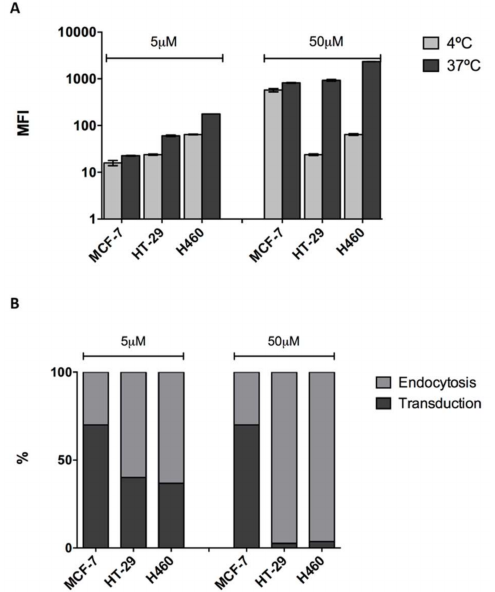
Figure 4. Temperature effect on CIGB-552 internalization evaluated by flow cytometry. ( A ) A reduction in the internalization levels of CIGB-552 was observed at both concentrations used in all the cell lines when assays were performed at 4 ◦ C. However, reduction levels were not the same between cell lines. Both HT-29 and H460 displayed a higher reduction in internalization levels as reflected by values obtained at 37 ◦ C and 4 ◦ C; ( B ) Estimated contribution of each internalization mechanism as a percentage (%) varied among cell lines. The contribution of transduction in MCF7 cell line is distinctively higher than that occurring in the HT-29 and H460